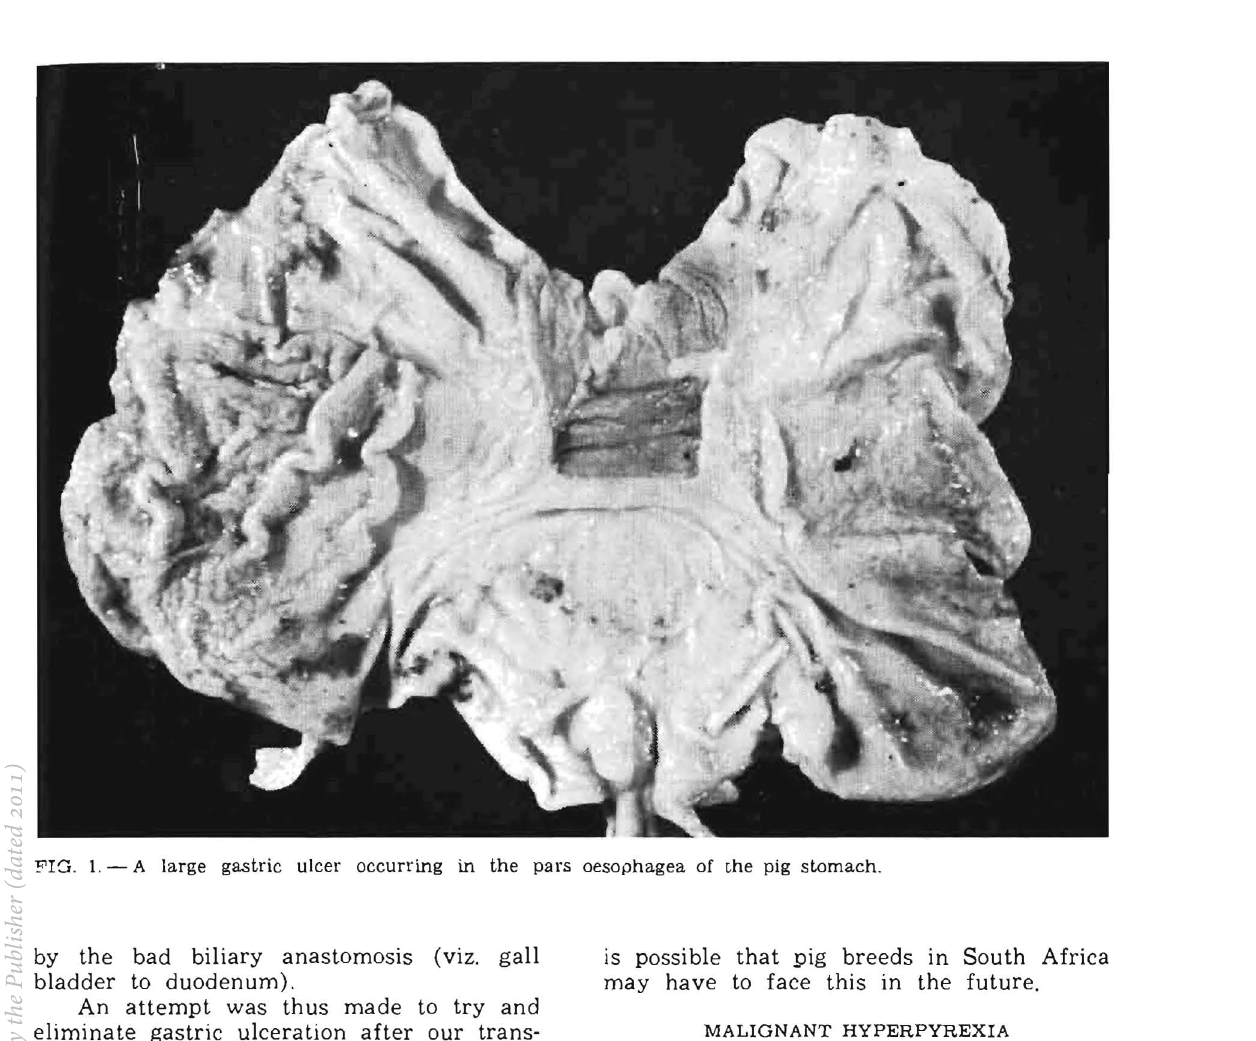
by the bad biliary anastomosis (viz. gall bladder to